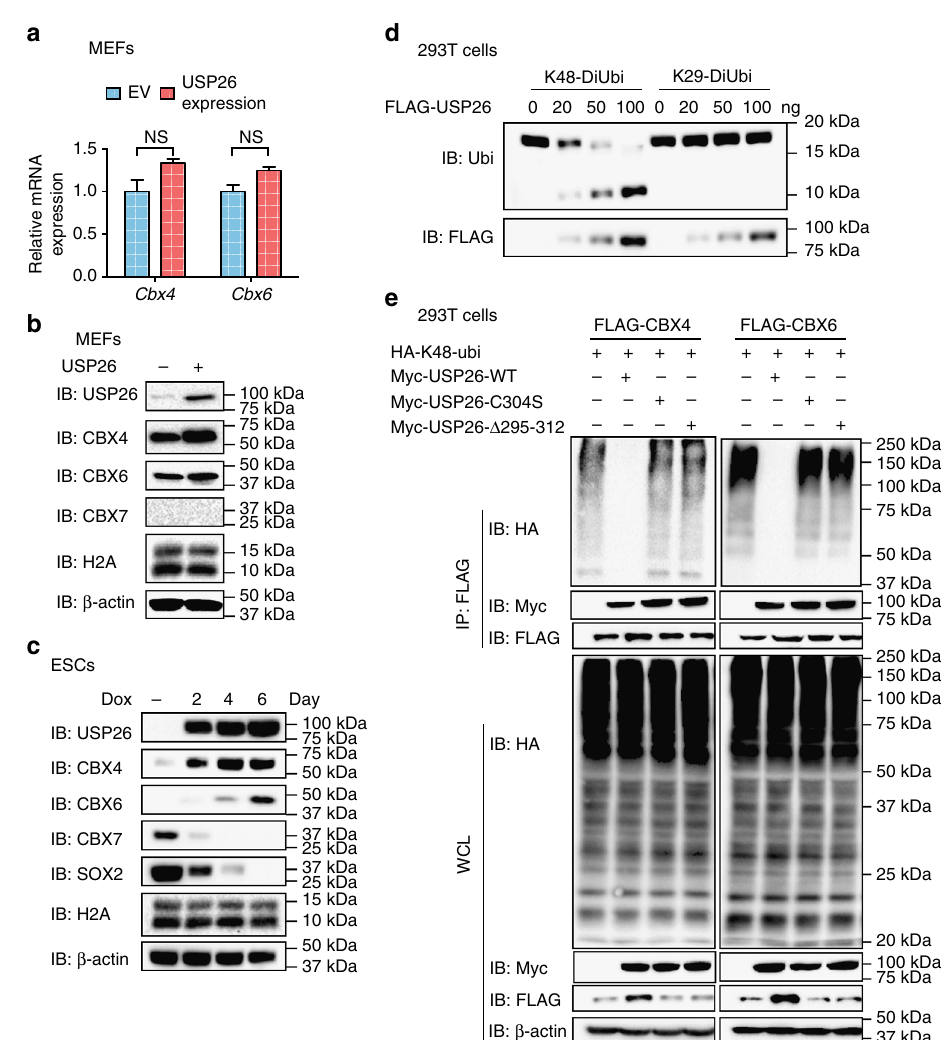
Fig. 5 USP26 stabilizes CBX4 and CBX6 proteins by removing K48-linked polyubiquitination. a , b MEFs were transduced with mouse Usp26 or EV lentivirus, cell extracts were harvested, and mRNA levels were analyzed by qPCR a . Protein levels were analyzed by western blotting with speci fi c antibodies b , as indicated. c Mouse ESCs were infected with Dox-inducible m Usp26 lentivirus, and cell lysates were harvested on days 0, 2, 4, and 6 and analyzed by western blotting using the indicated antibodies. d Deubiquitinase activity assay of USP26. Puri fi ed USP26 was incubated with K48-linked or K29-linked ubiquitination chains for 3 h. Cleaved Ub was detected by western blotting with anti-Ub antibody. e 293T cells were transfected with HA-tagged K48-linked Ub, FLAG-CBX4, or FLAG-CBX6 with or without Myc-tagged WT or Myc-tagged mutant (C304S or Δ 295-312) USP26. Following IP with anti- FLAG beads, ubiquitination of CBX4 or CBX6 was analyzed by western blotting using anti-HA antibody. The data are presented as means ± SD from three independent experiments. a Unpaired two-tailed Student ’ s t